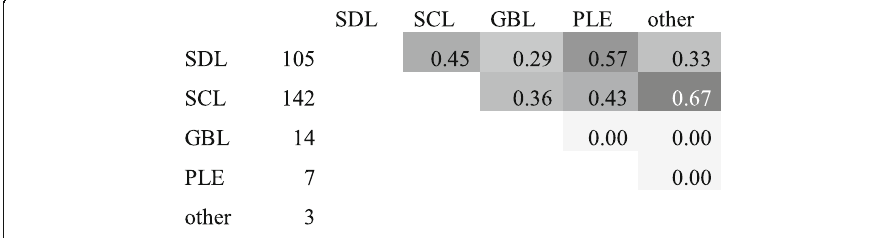
Fig. 6 Co-occurrence of learning scenarios across the sample ( n = 243). Note. SDL = self-directed learning; SCL = social collaborative learning; GBL = game-based learning; PLE = personal learning environments; other = other learning